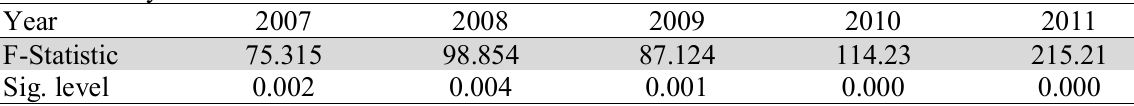
The summary of Fisher